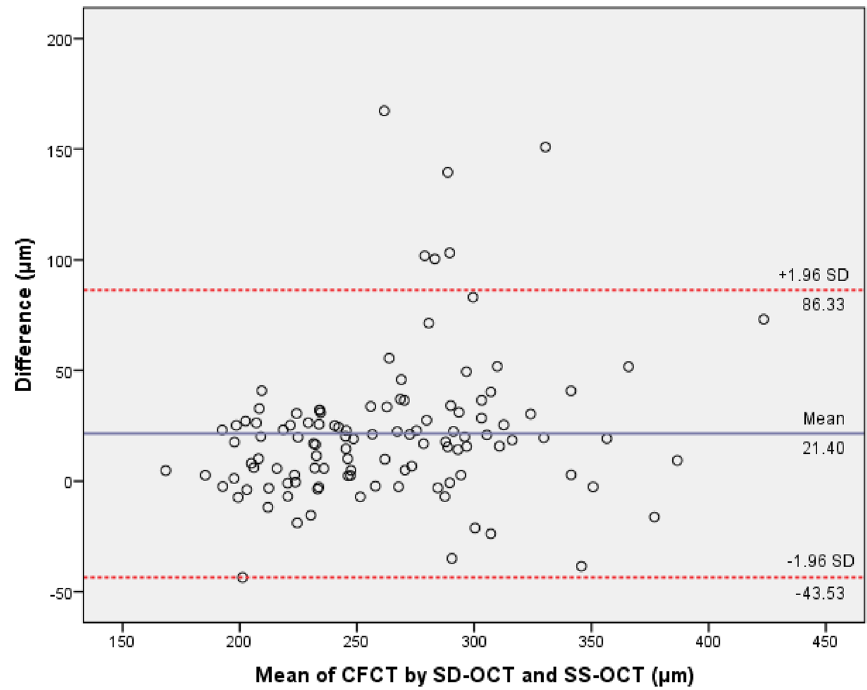
Figure 4. Bland–Altman plots comparing choroidal thickness measurements between spectral-domain optical coherence tomography (SD-OCT) and swept-source optical coherence tomography (SS-OCT) in healthy paediatric eyes.